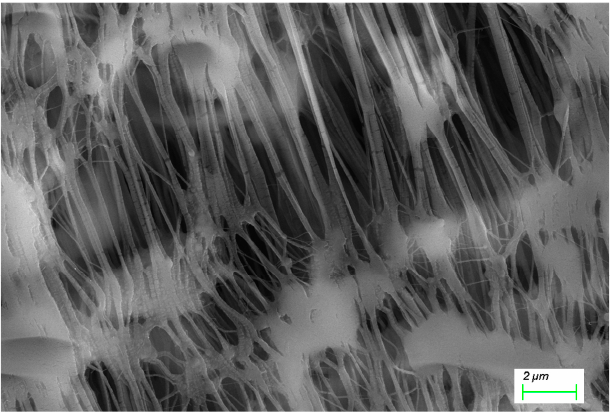
Figure 1. SEM image of unused PTFE membrane. Table 1. Detailed specifications of PTFE membrane used in this study as specified by the manufacturer.